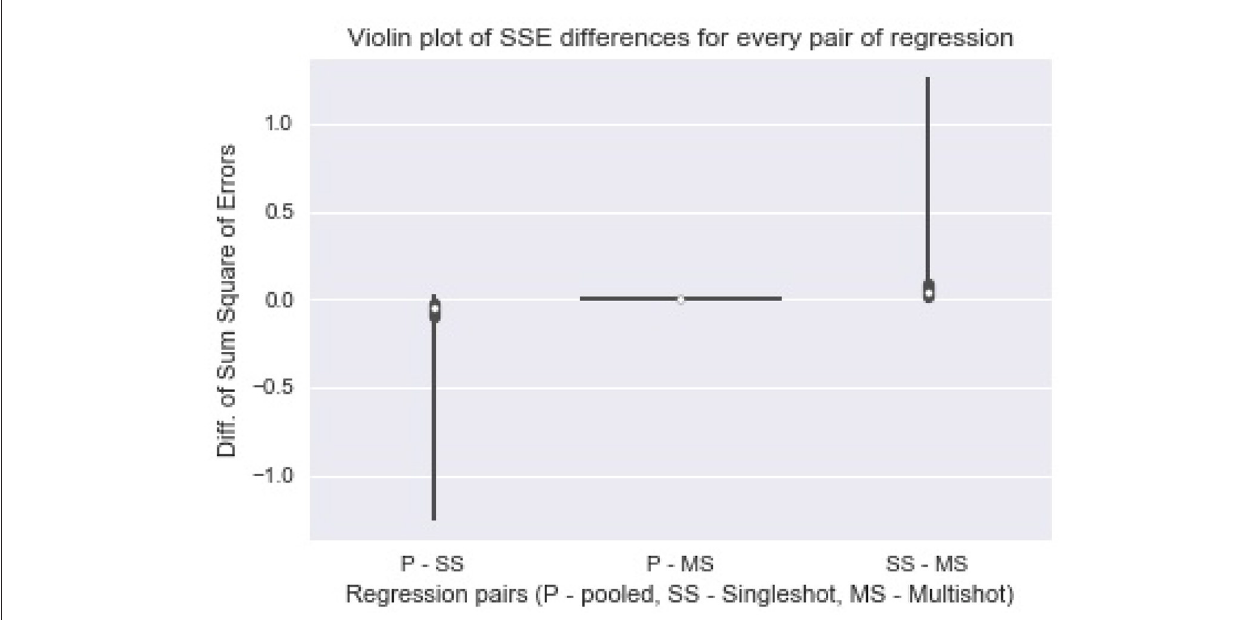
FIGURE 2 | Violin plot of Sum Square of Error differences between every pair of regression. The plot of differences in SSE from pooled regression and multi-shot regression (P-MS) centered around 0 demonstrates how identical the results from the two regressions are. On the other hand, the SSE values from single-shot regression are higher compared to those from the pooled